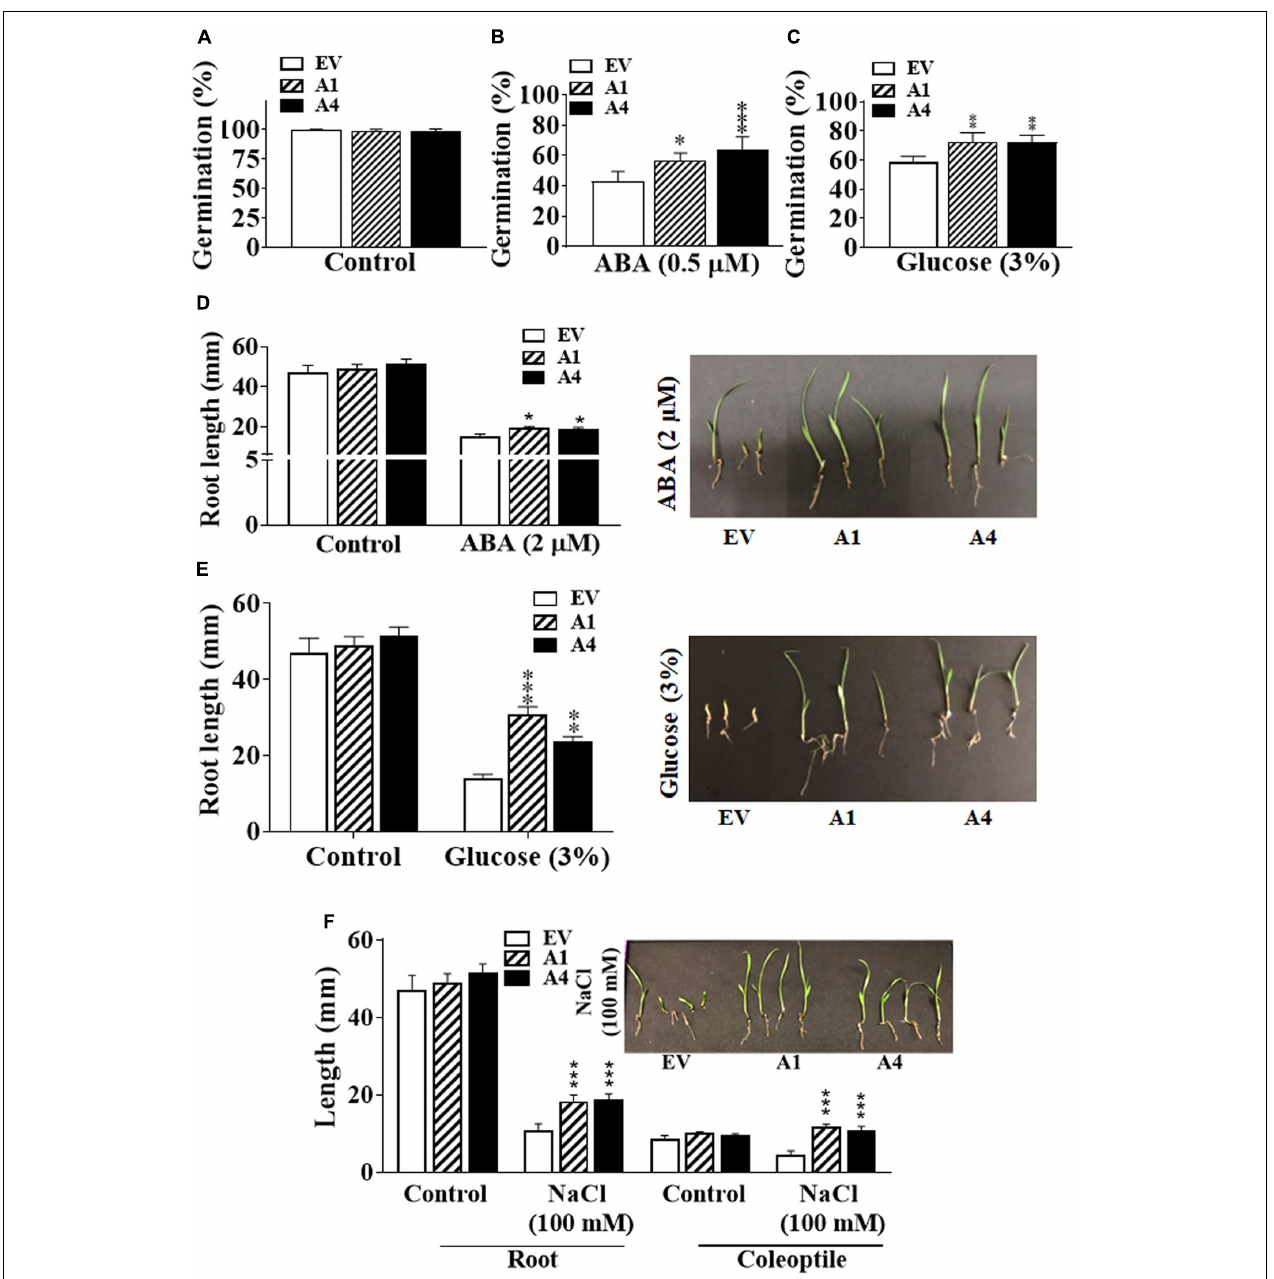
FIGURE 2 | Effect of different abiotic stresses on early development of Setaria AGG3OE plants. (A) Percentage of seed germination in EV, A1, and A4 transgenic seeds under control conditions. (B) Percentage of seed germination in EV, A1 and A4 transgenic seeds in the presence of 0.5 X MS media containing 0.5 µ M ABA or (C) 3% glucose. For these experiments, 24 seeds per genotype, per treatment were used. Seeds were sterilized and stratified at 4 ◦ C for 2 days. Seed germination was calculated as the percentage of total seeds that germinated after 5 days post-stratification. The data represent mean values ( ± SE) of three biological replicates. (D) Post-germination seedling growth of EV and A1 and A4 transgenic plants in the presence of 2 µ M ABA, (E) 3% glucose or (F) 100 mM NaCl. Seeds were germinated on 0.5 X MS agar for 2 days followed by their transfer to the media containing different additives and grown for another 3 days. Root and coleoptile lengths were measured. The graphs represent the mean values ( ± SE) from sixty seedlings. The corresponding representative pictures are also shown. Asterisks represent P -values ≤ 0.05 ( ∗ ), ≤ 0.01 ( ∗∗ ), or ≤ 0.001 ( ∗∗∗ ) as calculated using Students t- test.